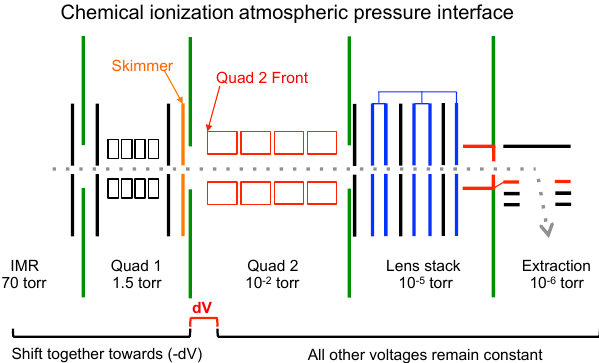
Figure 2. A schematic of the voltages in the APi region of the Tofw- erk ToF-MS. The region of the mass spectrometer that we conduct declustering scanning is between the skimmer (orange) and the en- trance to the second quadrupole (red). All voltages upstream of the skimmer are moved incrementally towards more negative voltages to create a stronger declustering field while keeping mass trans- mission effects constant by keeping the voltage gradients across each quadrupole constant, typically in steps of − 1V. Iodide adducts which are formed in the ion molecule region (IMR) interact with the changing electric fields and dissociate based on their ion–molecule binding energy. Figure 3. Effective binding energy. Top: declustering scans of gas-